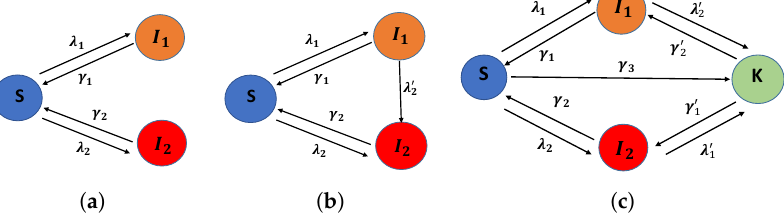
Figure 2. Two-pathogen models with cross-immunity infection, super-infection, and co-infection forms, respectively: ( a ) cross-immunity; ( b ) super-infection; ( c ) co-infection. Table 1. Notation used in